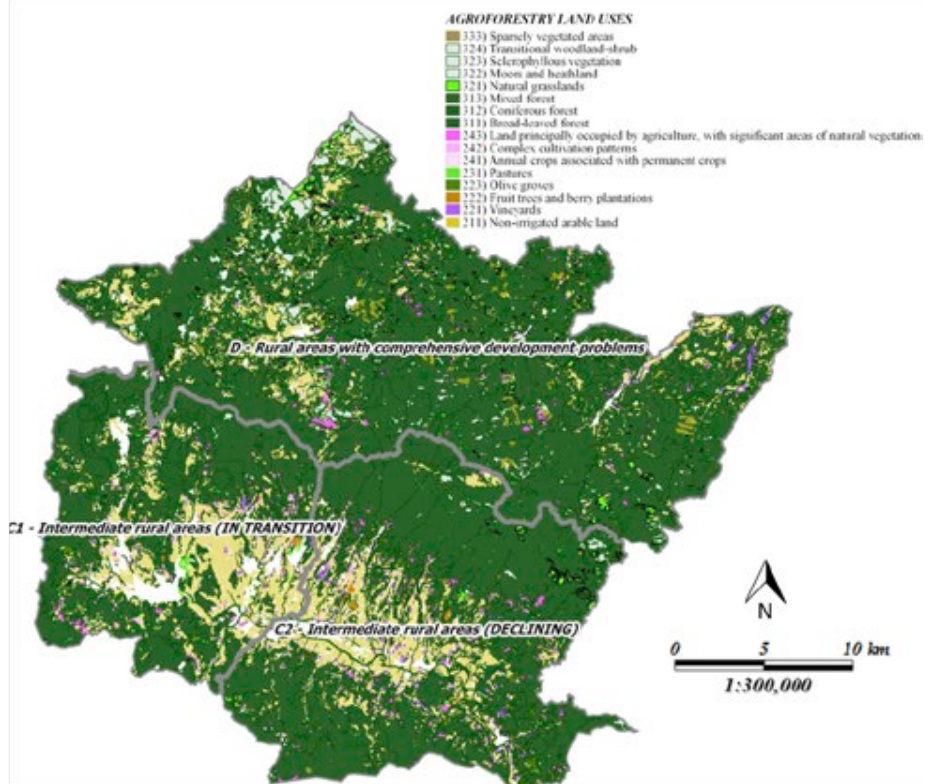
Figure 2 . Land use in